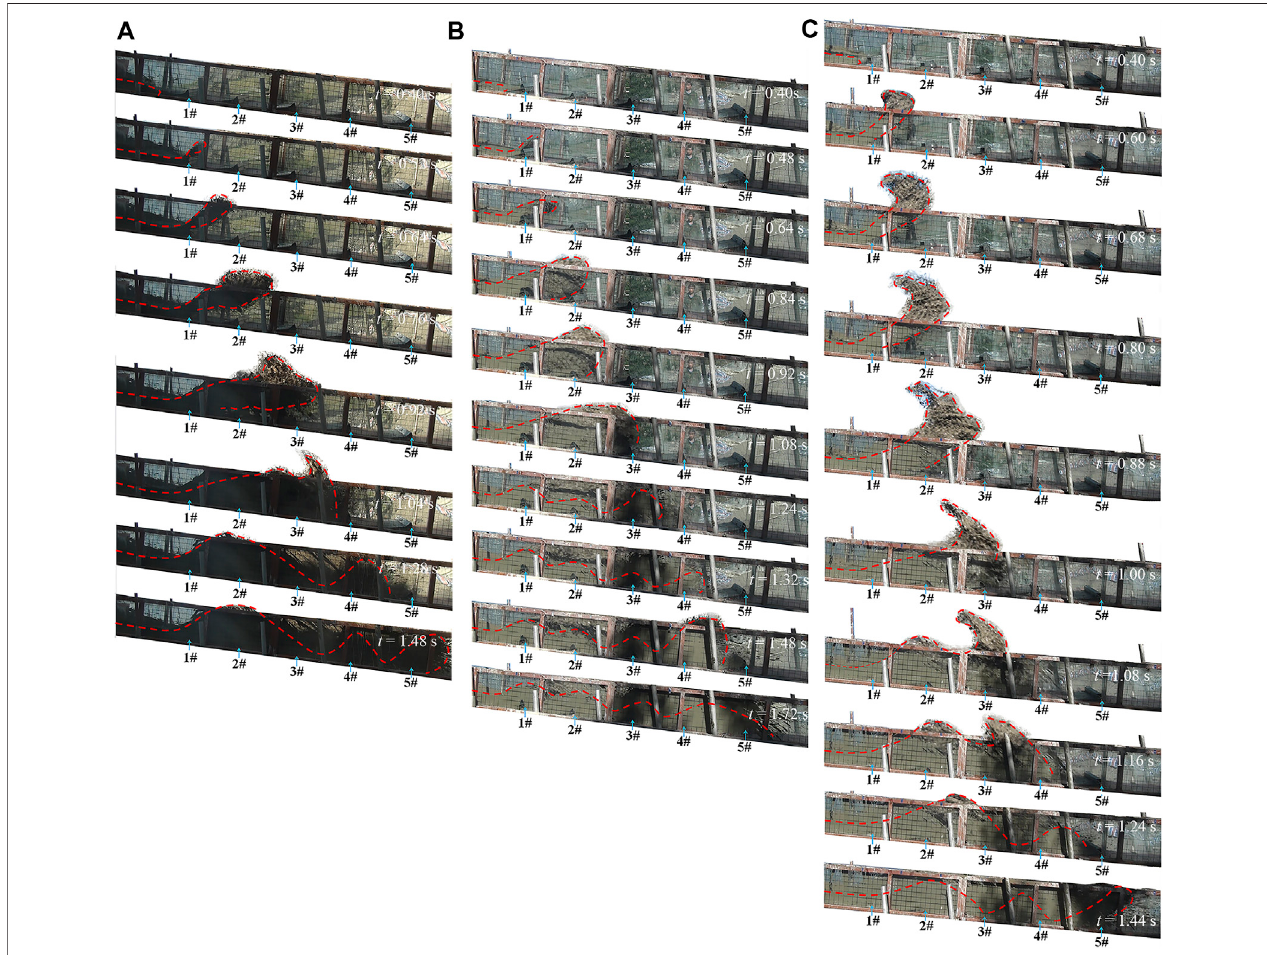
FIGURE 6 | The evolution of debris fl ow pro fi les (C s = 0.55) in the drainage channel: (A) step + triangular baf fl e; (B) step + trapezoidal baf fl e; and (C) step + square baf fl e.